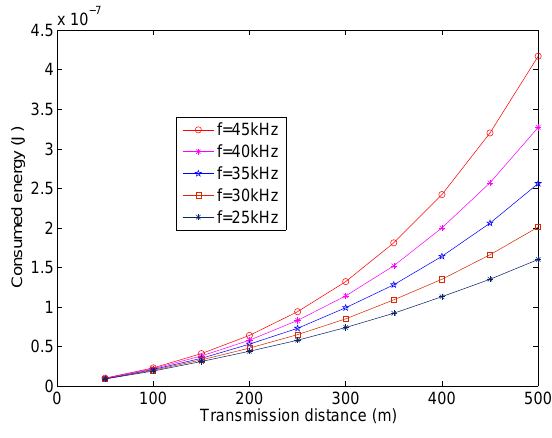
Figure 9. Energy dissipation vs sensor nodes in deep